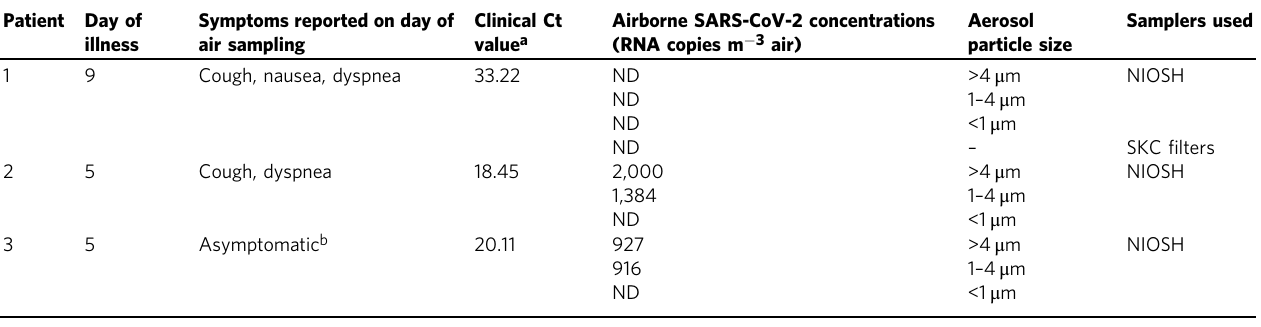
Table 1 Severe acute respiratory syndrome coronavirus 2 (SARS-CoV-2) detections in the air of hospital rooms of infected